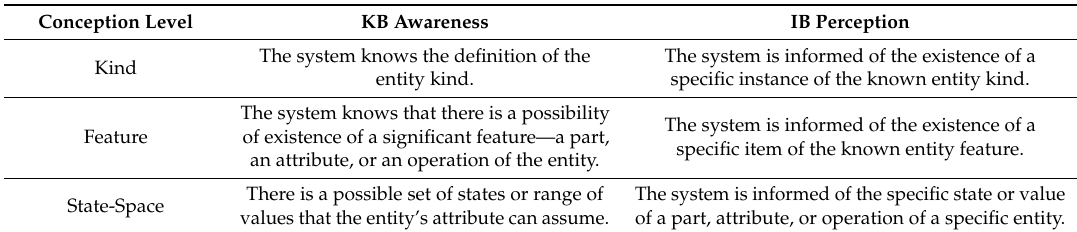
Table 1. Levels of Systemic Conception of